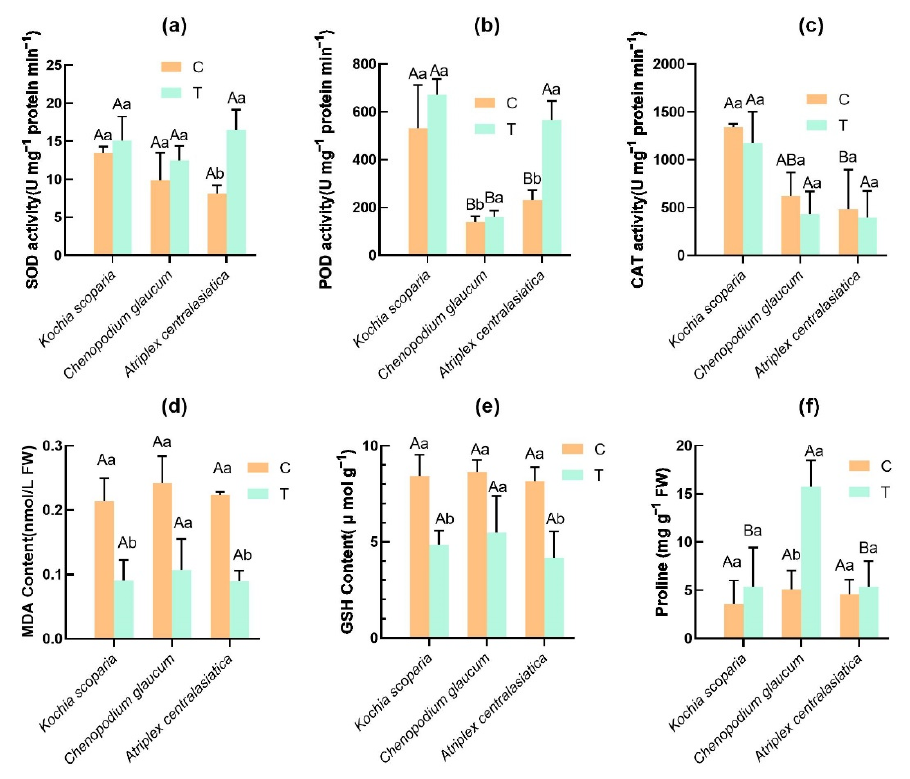
Figure 4. Physiological changes in leaves of three plants after tailing stress. Bars indicate mean ± SD ( n = 3). Different capital letters indicate significant differences between groups (between different plants) and different lowercase letters indicate significant differences within groups (control and treatment of the same plant) using the Tukey test ( p < 0.05). C represents the control group; T represents the experimental group. ( a ) Effects of heavy metal Stress on SOD activity of the three plants. ( b ) Effects of heavy metal stress on POD activity of the three plants. ( c ) Effects of heavy metal stress on CAT activity of the three plants. ( d ) Effects of heavy metal stress on MDA content of the three plants. ( e ) Effects of heavy metal stress on GSH content of the three plants. ( f ) Effects of heavy metal stress on Proline of the three plants.